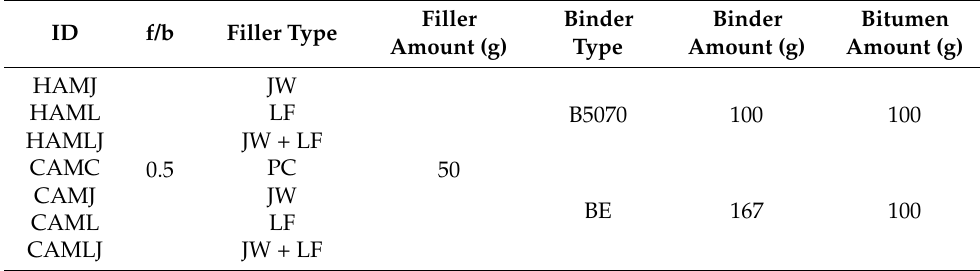
Table 3. Asphalt mastic composition.